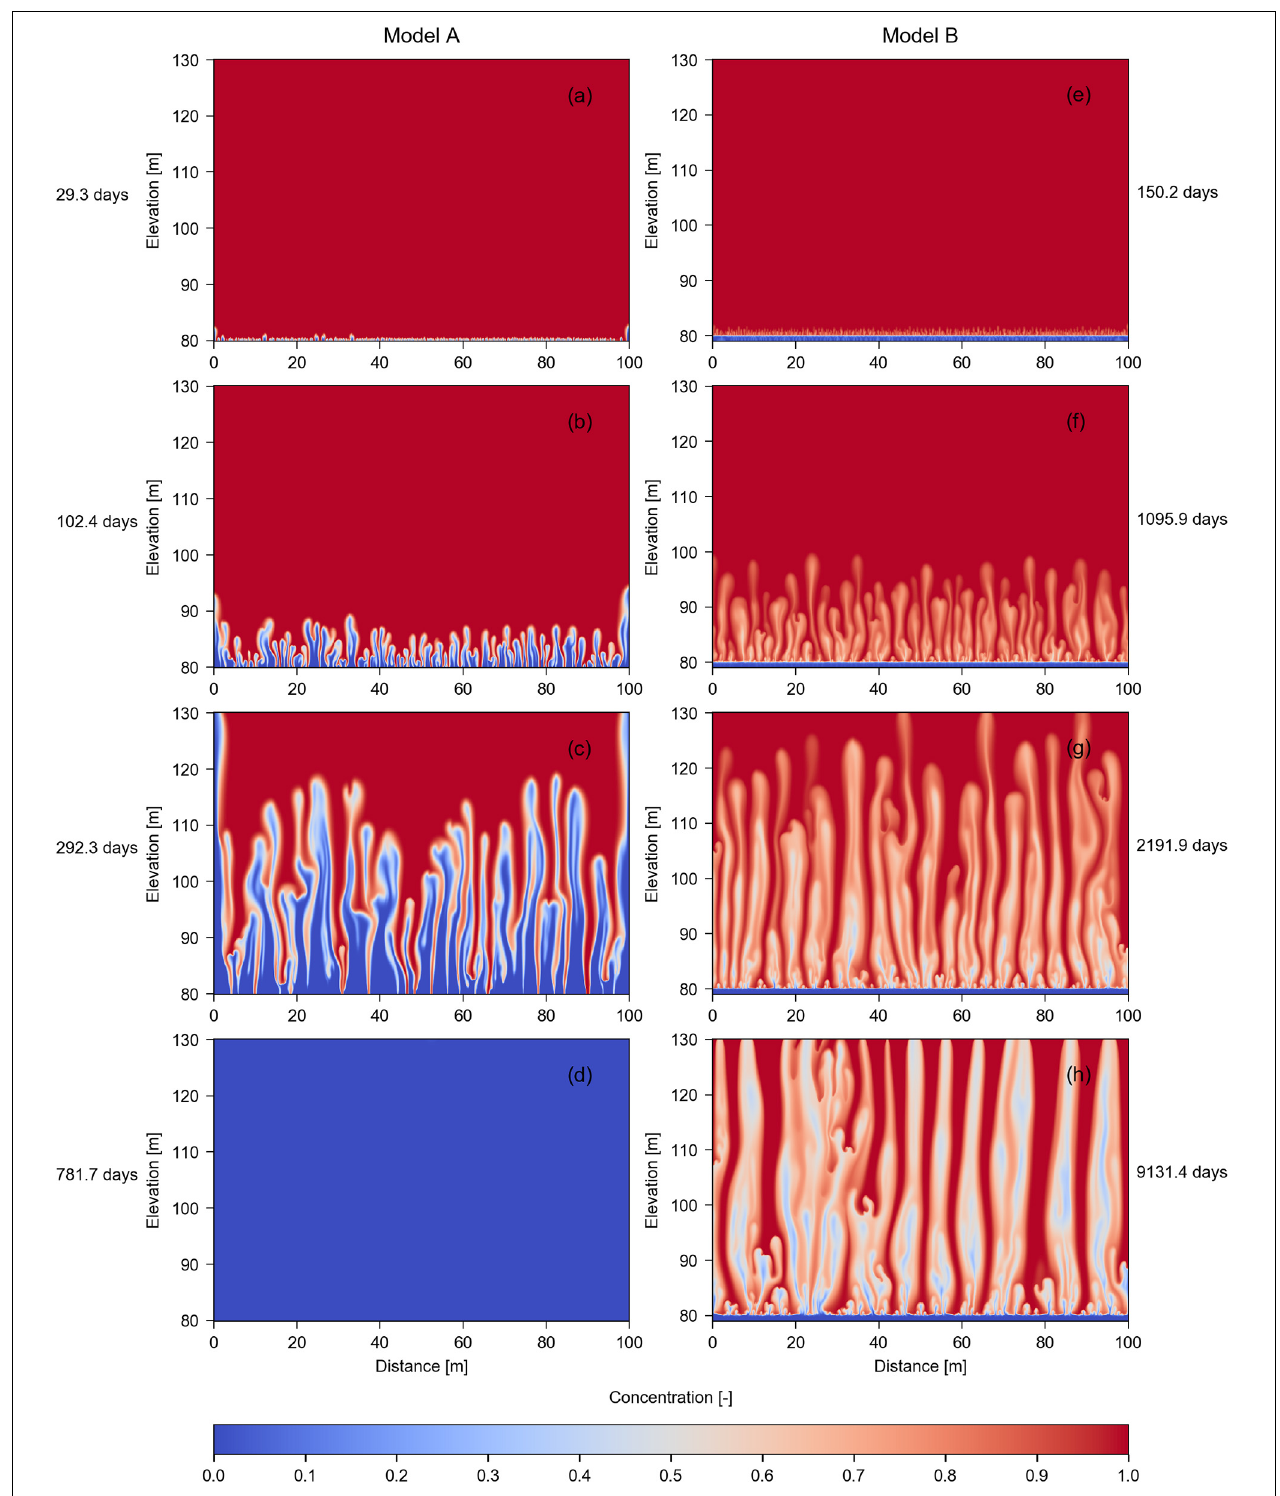
FIGURE 3 | Salinity distributions in seafloor sediments obtained from simulations of the Base Case (i.e., α L = 0.1 m; α T = 0.01 m) of Model A (left column) and Model B (right column) at various simulation times. Concentration values represent the relative seawater concentration, where 0 and 1 are freshwater and seawater, respectively. The bottom left subplot depicts steady state results, while the bottom right subplot shows a quasi-steady state salinity distribution. (a) 29.3 days; (b) 102.4 days; (c) 292.3 days; (d) 781.7 days; (e) 150.2 days; (f) 1095.9 days; (g) 2191.9 days; (h) 9131.4 days.